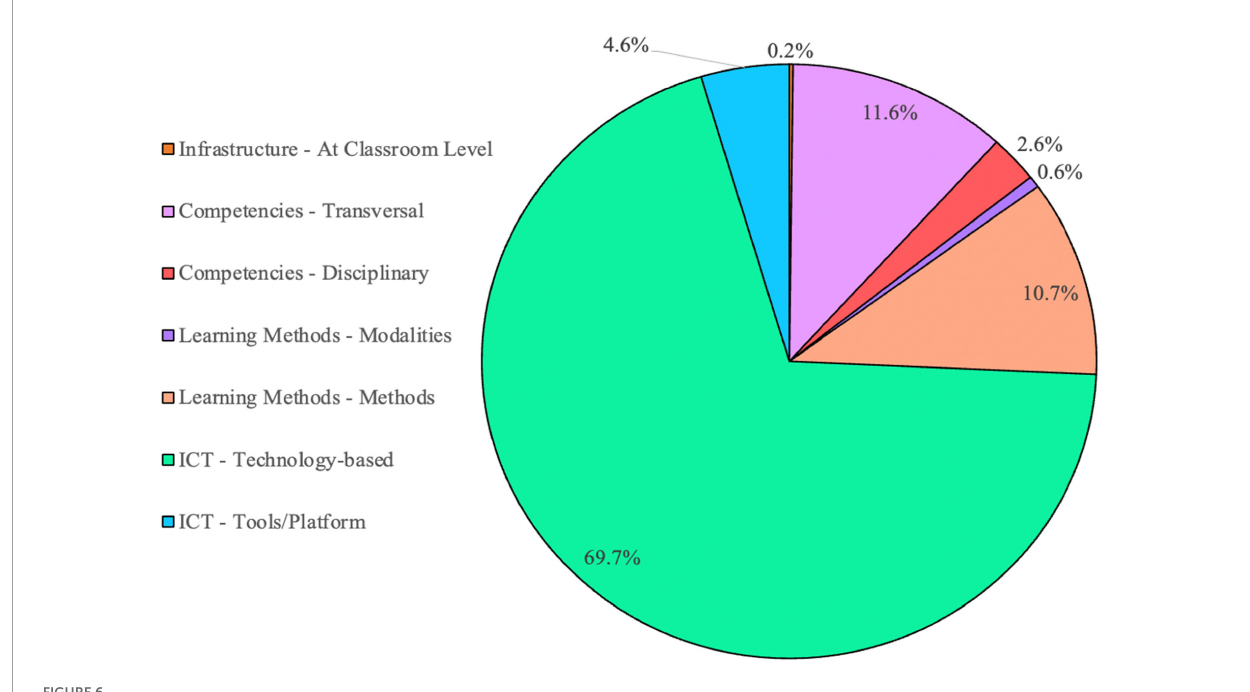
FIGURE6 Core components of E.D. 4.0, identified by